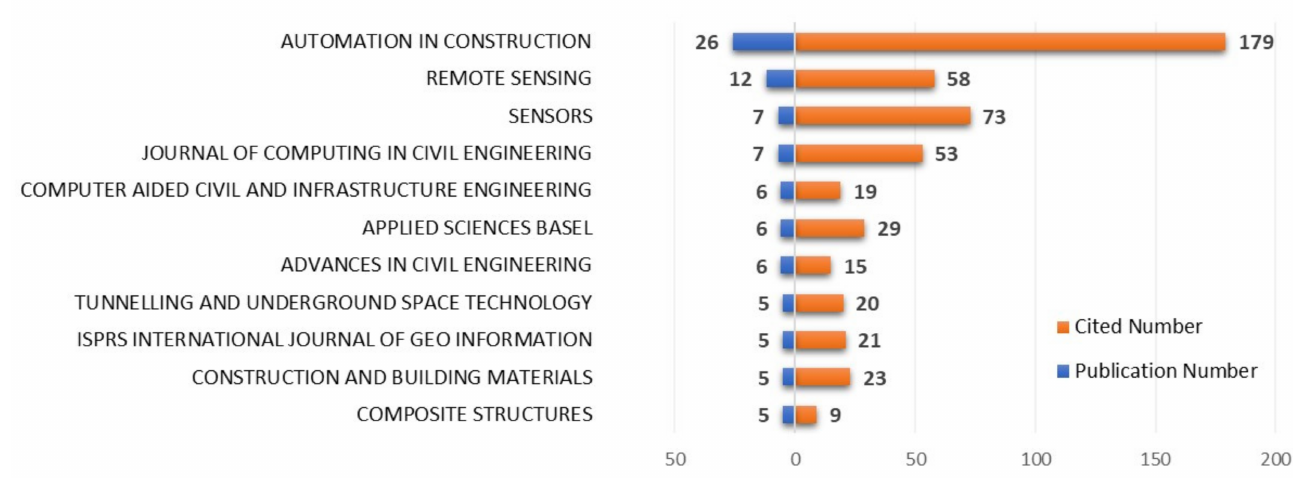
Figure 4. Top 10 journals in terms of publication number and number of